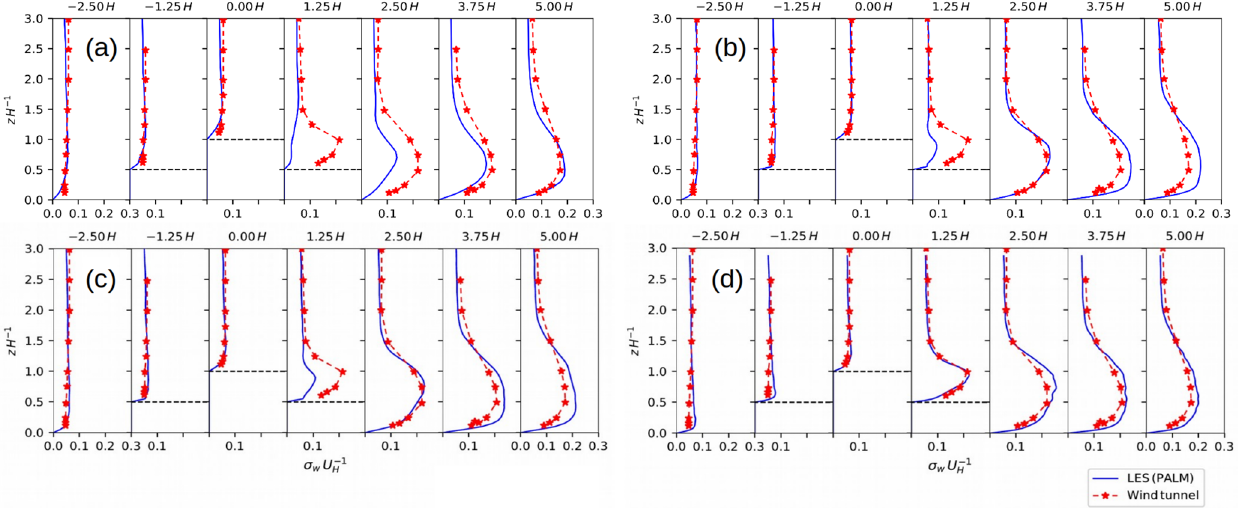
Figure 15. The 2h time-averaged vertical profiles of the standard deviation of the w component for the LES and the observed wind tunnel flow for (a) the 4m reference simulation, (b) the 2m reference simulation, (c) the 2m nested child simulation, and (d) the 1m nested child simulation. The ordinate is scaled with the hill height H . The standard deviation is normalized with the reference wind speed taken at z = H upwind of the hill. The horizontal dashed black lines indicate the discrete height of the surface at the sampling location. Note that the vertical dimension of the 1m nested child domain does not cover the entire vertical range of the measurements, and thus some data points from the LES are missing on the normalized height coordinate in (d)